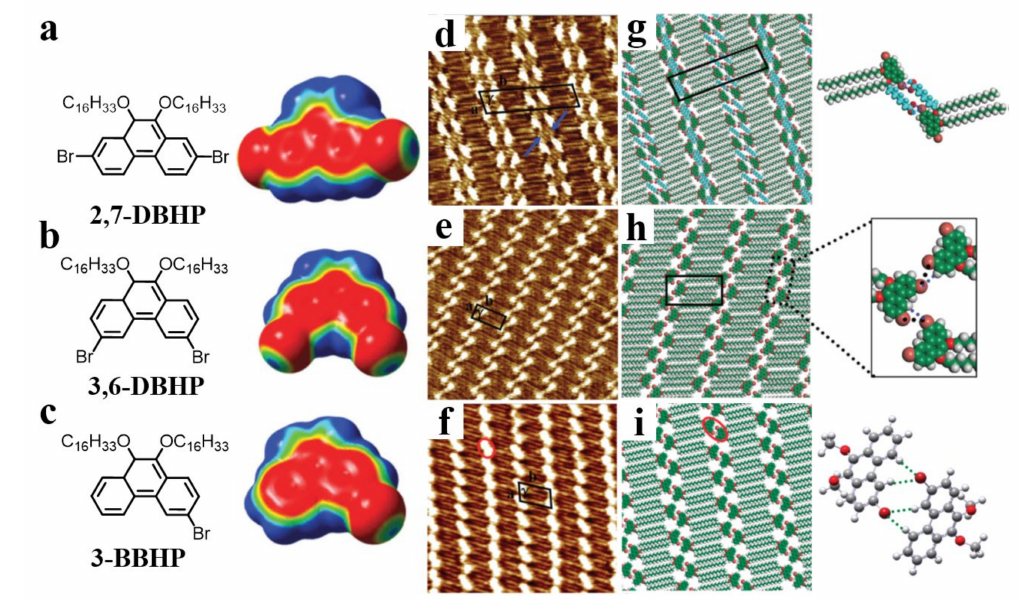
Figure 12. ( a – c ) Molecular structures and their calculated 3D ESP maps of 2,7-DBHP, 3,6-DBHP, and 3-BBHP, respectively. ( d – f ) Self-assembled networks formed by 2,7-DBHP, 3,6-DBHP, and 3-BBHP at the 1-octanoic acid / HOPG interface, respectively. Scanning area: 15 × 15 nm 2 . ( g – i ) Proposed molecular models of ( d – f ). Reproduced from [84] with permission from the Royal Society of